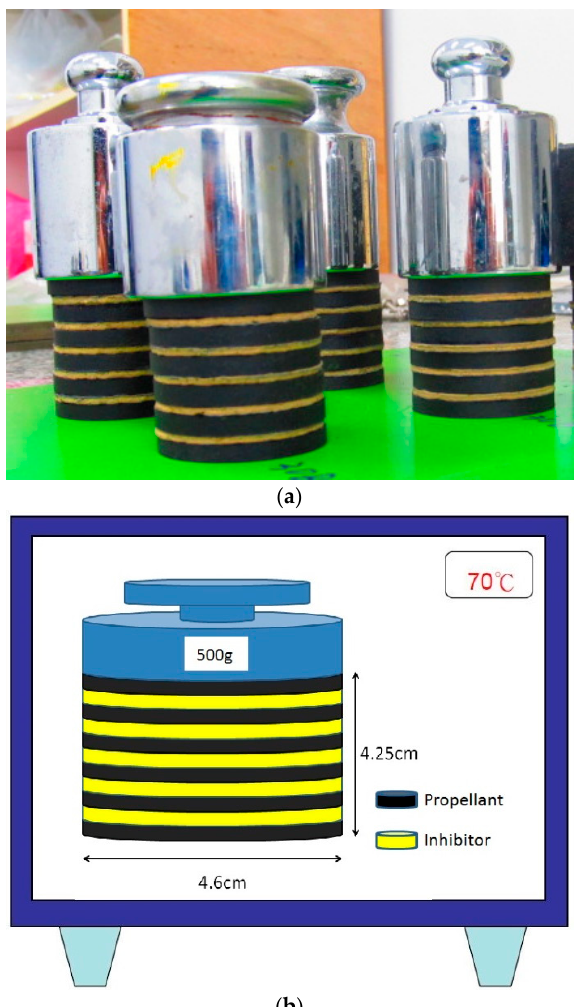
Figure 8. ( a ) Images of test specimens used in the nitroglycerine (NG)-migration and absorption experiments; ( b ) Illustration depicting the experimental set up for NG-migration and absorption experiments.